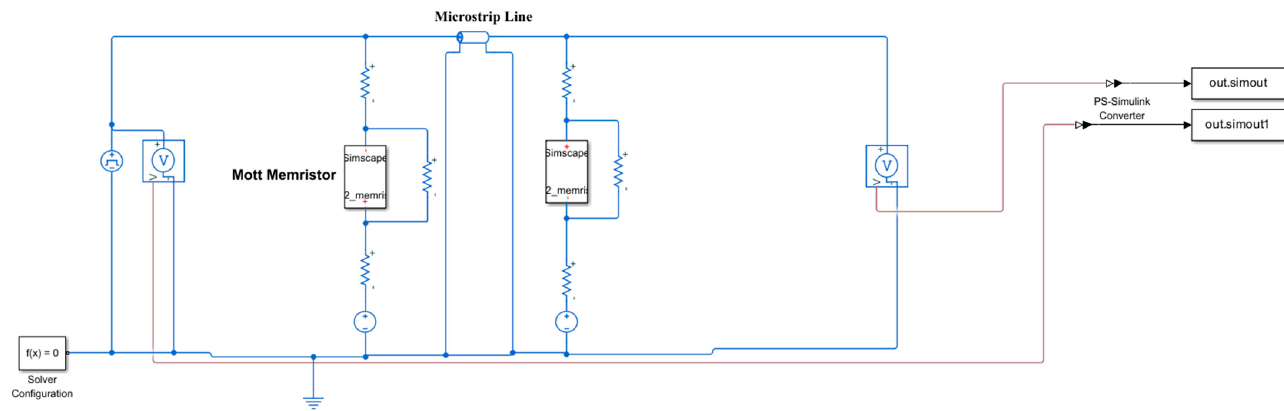
Figure 9. Building an Artificial Neural Circuit Based on Microstrip in Simscape. When the input voltage is 0.2 V, less than the threshold voltage, the input and output waveforms are in Figure 10. The brown line represents the input voltage pulse, while the blue one represents the output voltage (action potential).